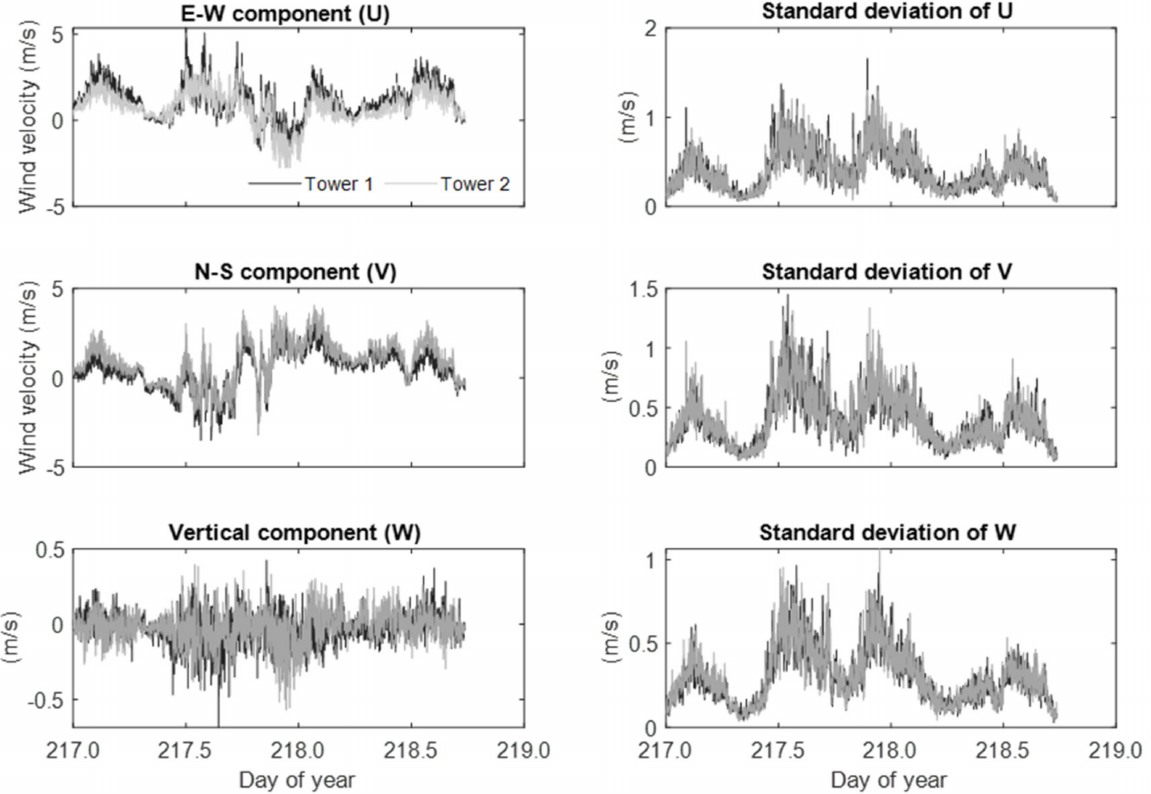
Figure 6. Comparison between 3-D sonic anemometers for tower 1 (black curves) and tower 2 (gray curves) during the EOSOLAR testing phase (Table 2). The original dataset was sampled at 20 Hz and presented here at a 1 min time